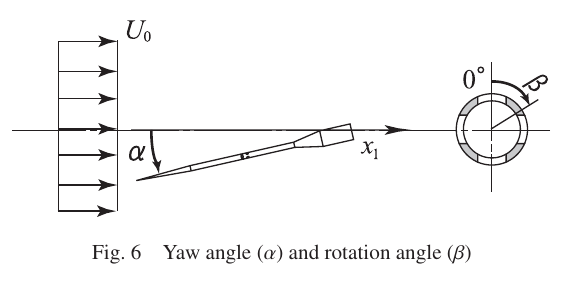
Fig. 6 Yaw angle ( α ) and rotation angle ( β )